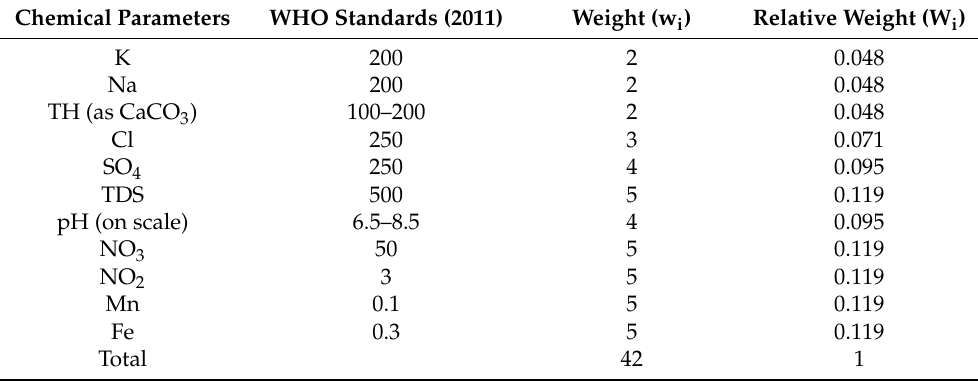
Table 1. The relative chemical weight of the physicochemical parameters (all values are in mg/L, except for